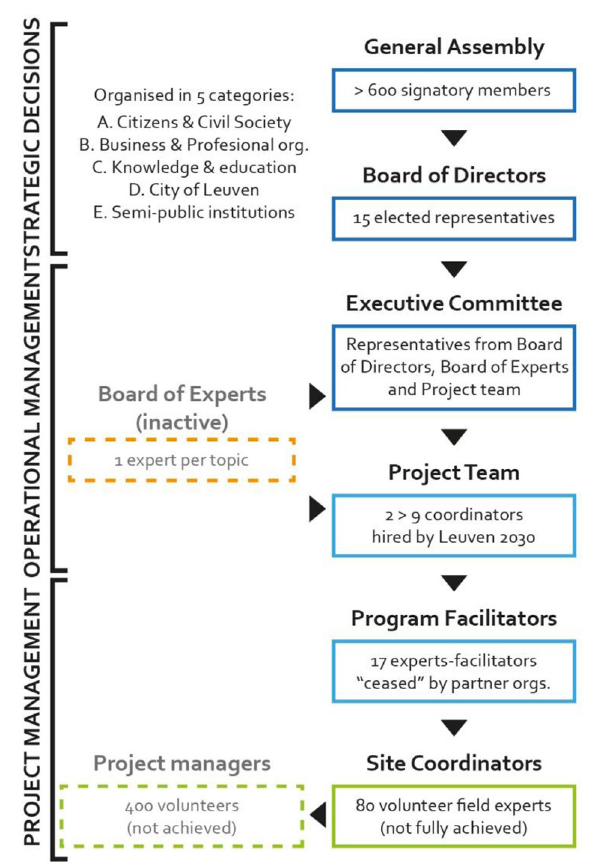
FIGURE 7 | Internal governance model in Leuven2030 as per update in